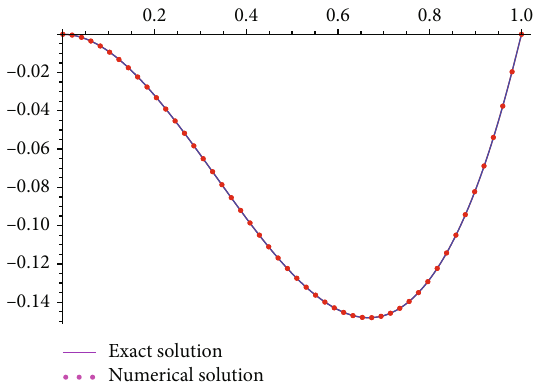
Figure 13: Comparisons between numerical and exact solutions of u 1 obtained by the present method for Example